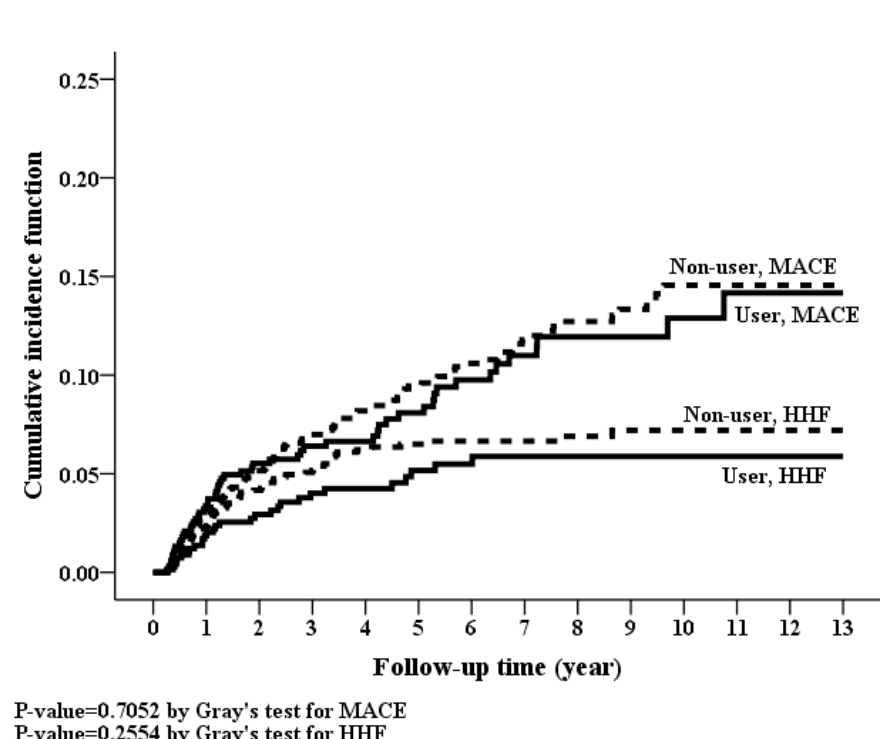
Figure 4. Cumulative incidence rate of hospitalization for heart failure ( p -value = 0.2554, Grey’s test) and major adverse cardiovascular events ( p -value = 0.7052, Grey’s test) between spironolactone users and non-users between spironolactone users and non-users.